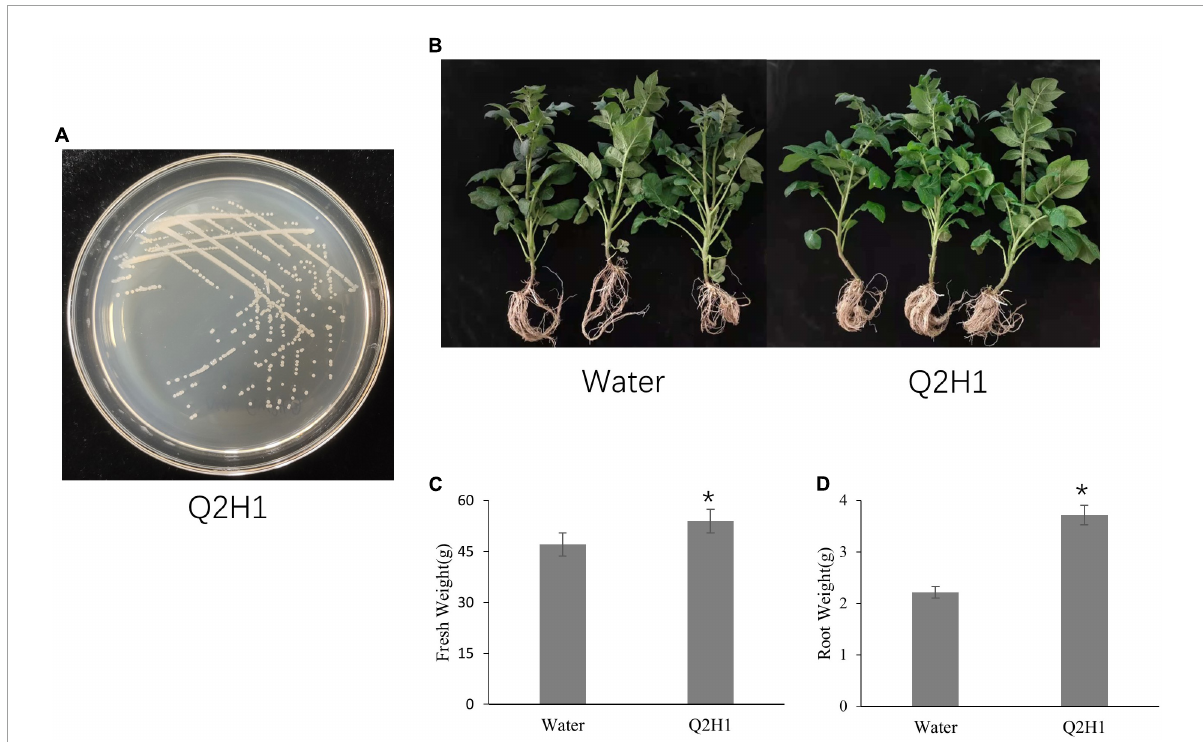
FIGURE1 Plant growth promotion of endophytic strain Q2H1 in potato: (A) Colony morphology of strain Q2H1 on LB medium; (B) photographs of potato plants at 30 days post-inoculation with Q2H1; (C,D) fresh weight and root weight of potato plants measured at 30 days post-inoculation with Q2H1; *show the significant differences ( P < 0.05) according to multiple ranges of